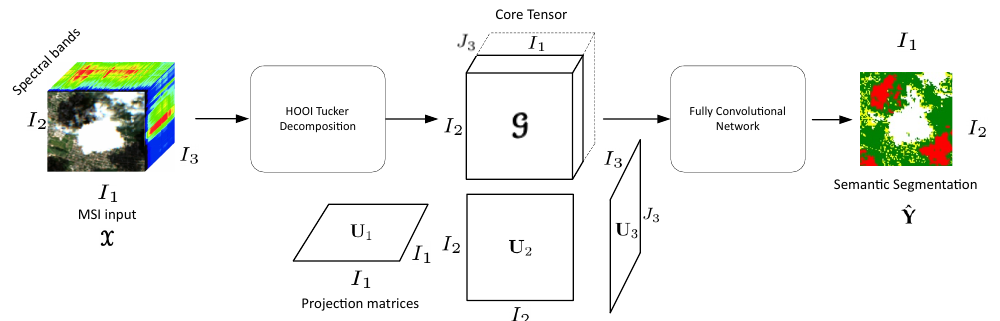
Figure 3. The big picture of the fast semantic segmentation framework proposed, with a fully convolutional network encoder-decoder architecture and a preprocessing HOOI tucker decomposition stage. Algorithm 1: HOOI for MSI. ALS algorithm to compute the core tensor GGG . Function HOOI( XXX , R 1 , R 2 , R 3 )